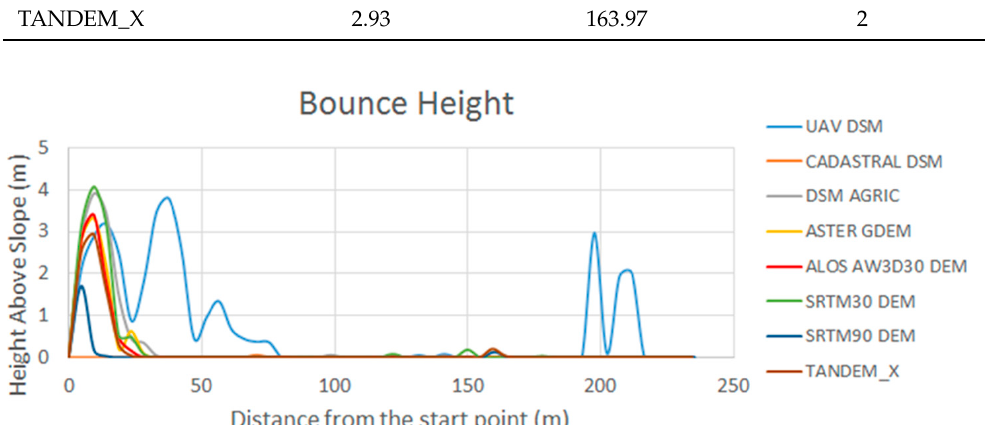
Figure 22. Bounce height for the 2nd slope profile.